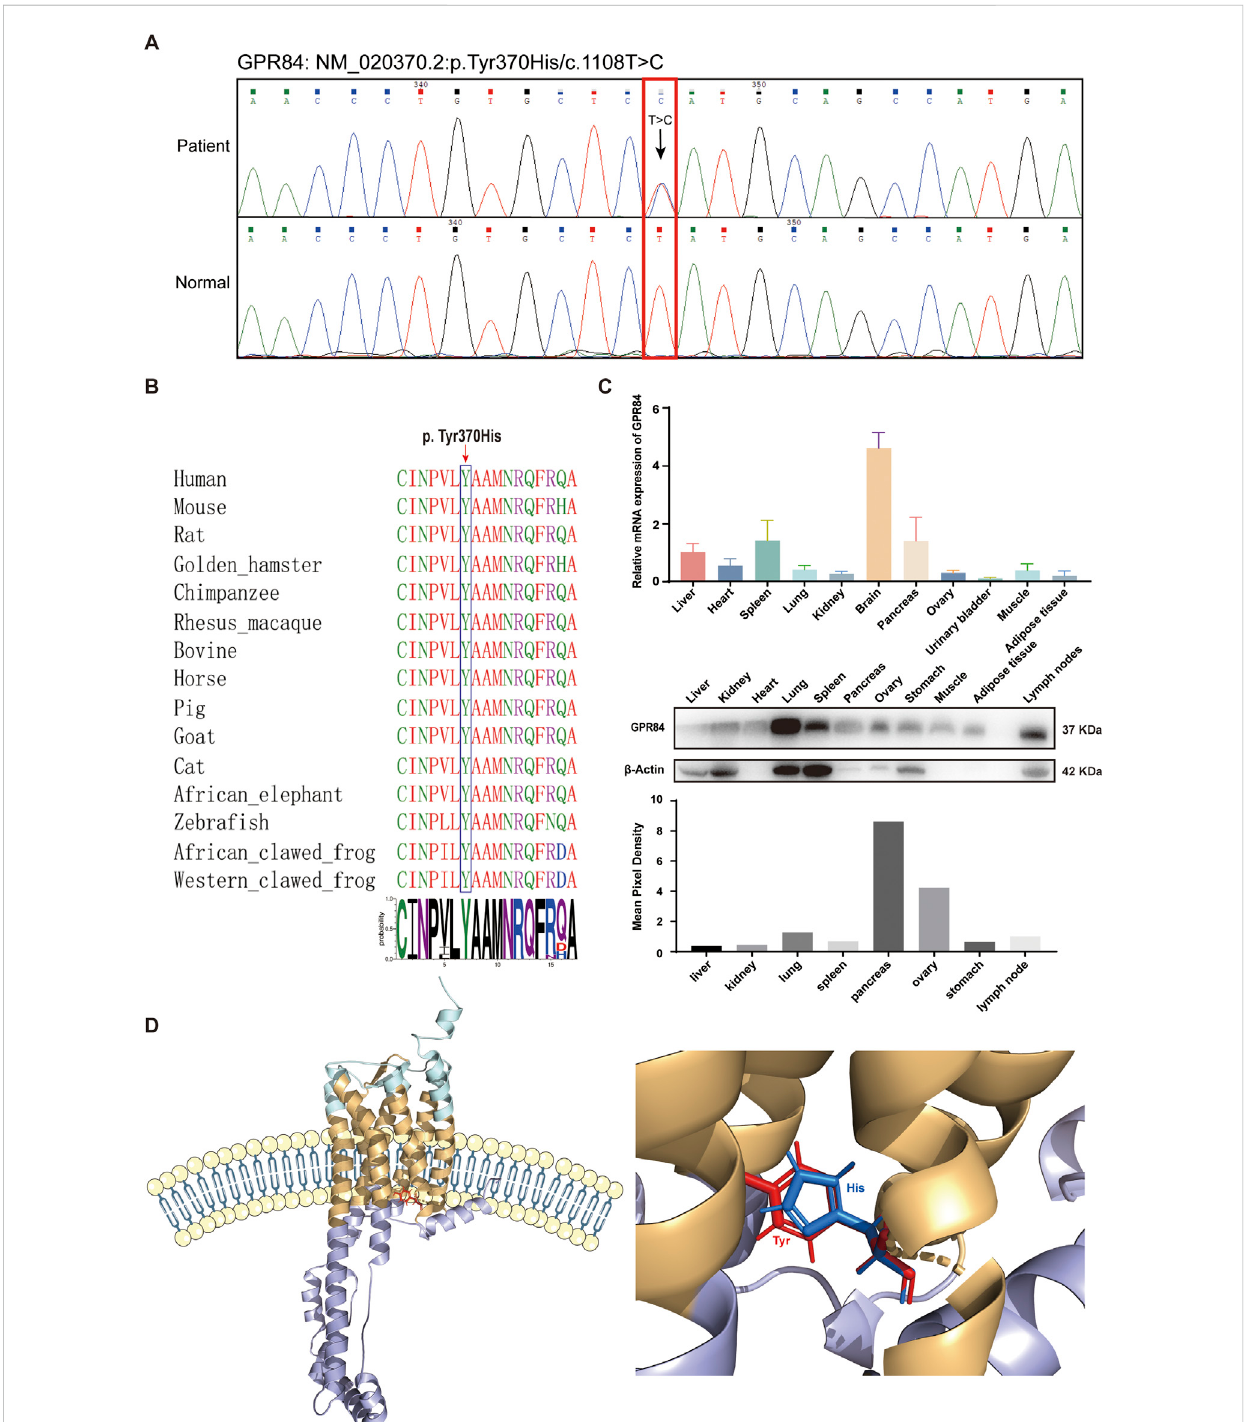
FIGURE 4 Characteristics of the GPR84 variant. (A) Sanger sequencing validation of the heterozygous c.1108T > C variant in the GPR84 gene. The red box indicatesthevariantsite. (B) AminoacidsequencealignmentofGPR84amongdifferentspecies.Theblueboxindicatesthemutatedaminoacid.Tyrosine atposition370is100%conservedacrossallspecies. (C) TheexpressionofGPR84indifferenttissueandorgansinBALB/cmouseweremeasuredbyqRT- PCR and Western blot. (D) Location of the mutated amino acid in the GPR84 protein predicted by RoseTTAFold. The extracellular segments are shown in cyan; the cytoplasmic segments are shown in violet; the transmembrane segments are shown in yellow. The wildtype amino acid tyrosine is shown in red, and the mutated amino acid histidine is shown in